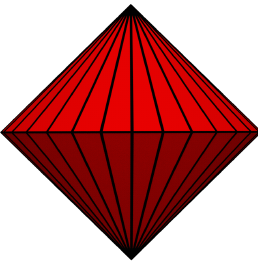
Figure 4. A Bipyramid with 64 faces. All faces are identical and mirror images of each other along the adjoining edge but as we increase the number of faces the compactness of the triangles reduces creating longer and skinnier